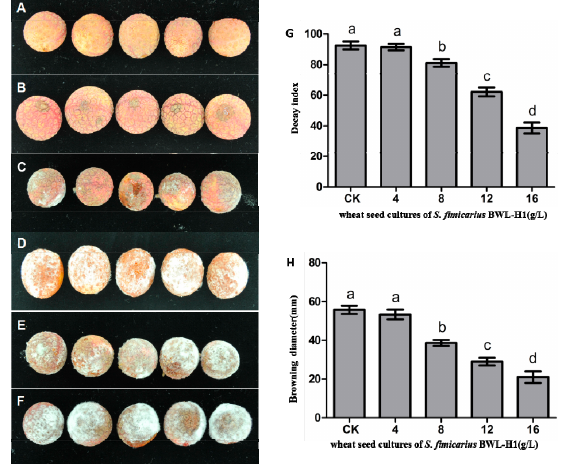
Figure 7. Antifungal activity of VOCs against P. litchii on fruits. ( A ) Negative control (without P.